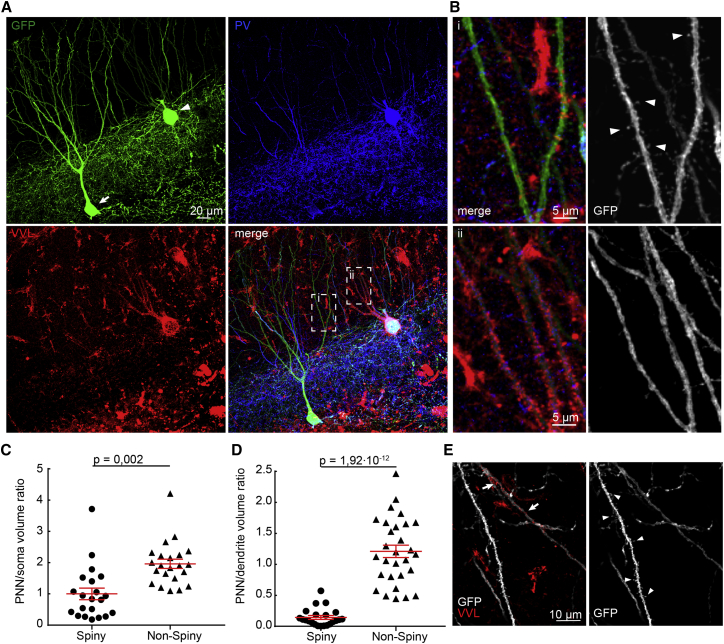
Spiny PVIs and Spiny Segments of PVIs Lack PNNs(A) Confocal image stack showing immunoreactivity for GFP (green) and PV (blue) as well as vicia villosa lectin staining for PNNs (red) for one spiny (arrow) and one non-spiny (arrowhead) PVI.(B) Left, magnifications of the boxed dendrites of the spiny (i) and the non-spiny (ii) PVI in the merged image in (A). Right, corresponding gray scale conversions of the GFP channel. Arrowheads indicate examples of spines. Note that PNNs strongly ensheathe soma and dendrites of the non-spiny neuron but not the spiny neuron.(C and D) Differences in PNN wrapping of somata (C) and dendrites (D) were quantified by calculating the individual volume ratios of the surrounding PNN and the respective soma or dendrite (n = 45 neurons, 5 mice).(E) Example image showing that spiny and non-spiny dendritic segments of the same neuron are differentially enwrapped by PNNs (arrows). Bars are means ± SEM.